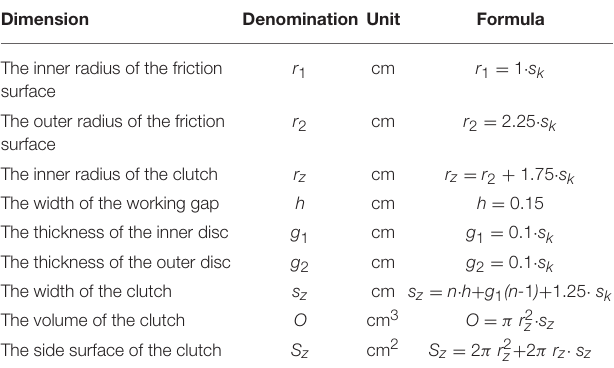
TABLE 1 | Dimensions of the clutch with ER fluid assumed for optimization.